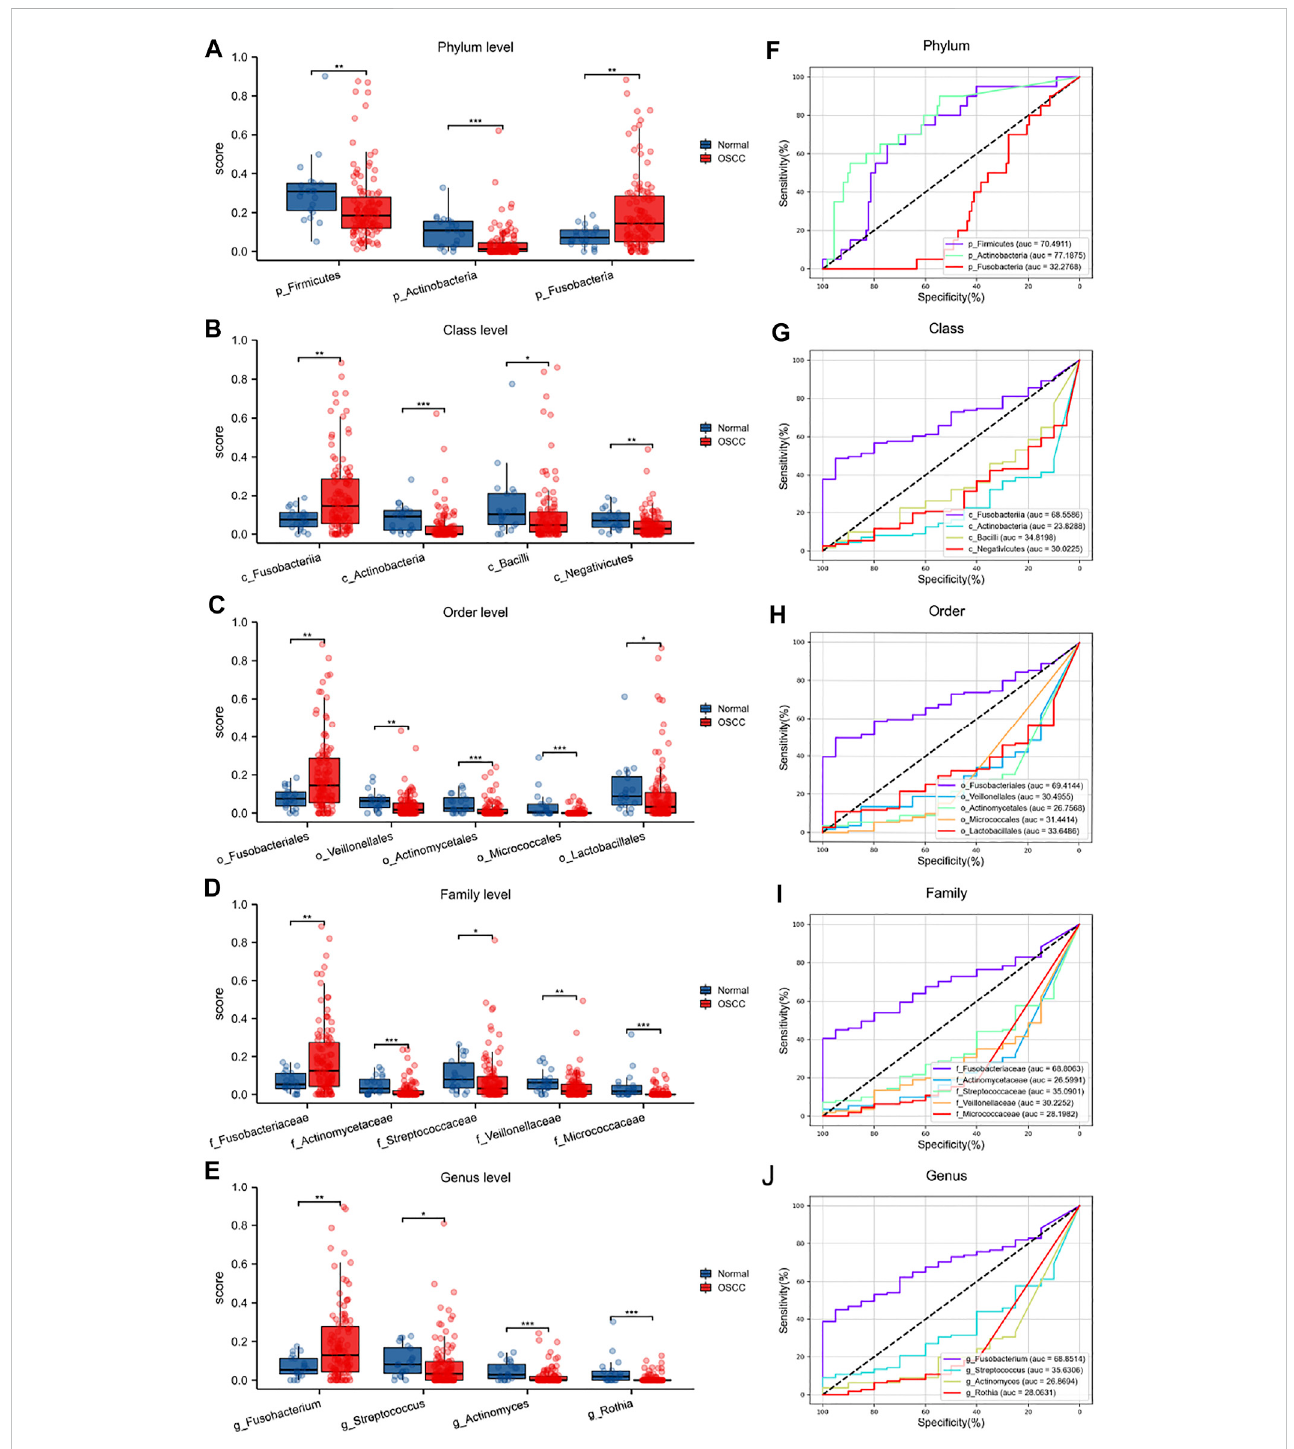
FIGURE 4 Differential oral microbiota composition and ROC analyses at different levels in OSCC tumors and normal tissues (A – E) (F – J) .